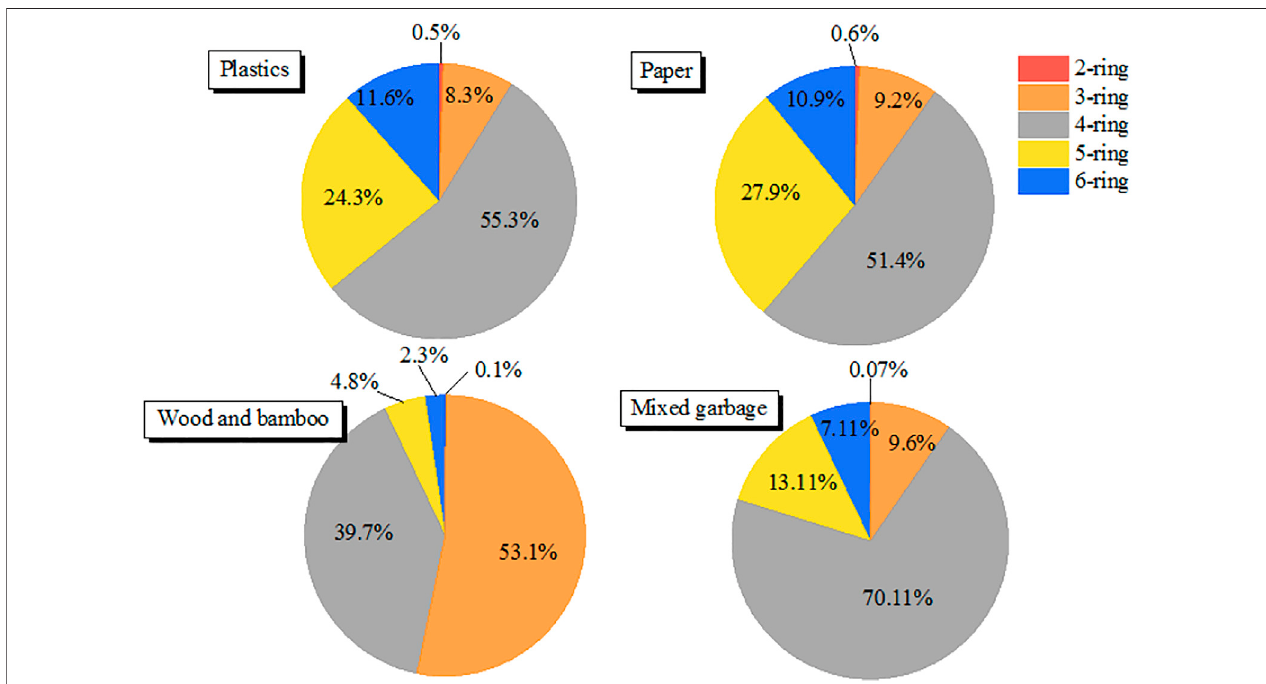
FIGURE 2 | The ring PAHs at different components of waste during open burning.